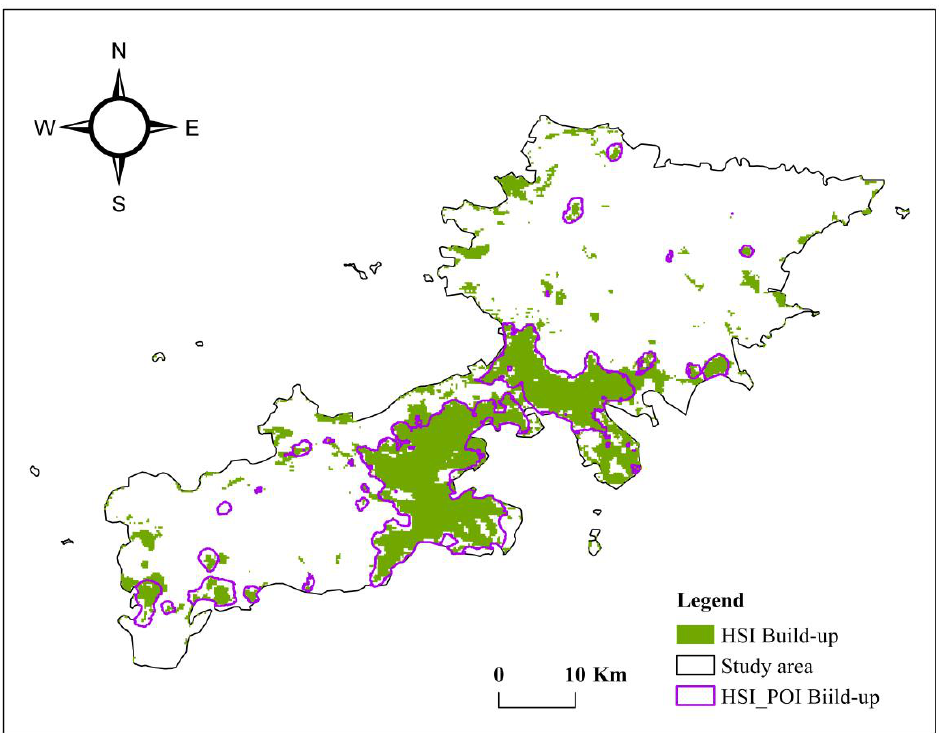
Figure 8. Comparison of the urban built-up area boundaries extracted using the HSI and HP indi- ces.